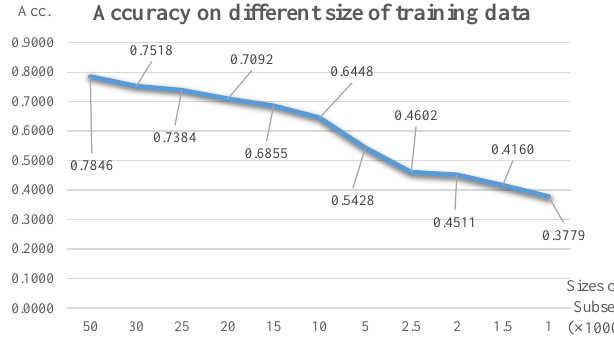
Figure 6. Learning performance of randomly selected data.